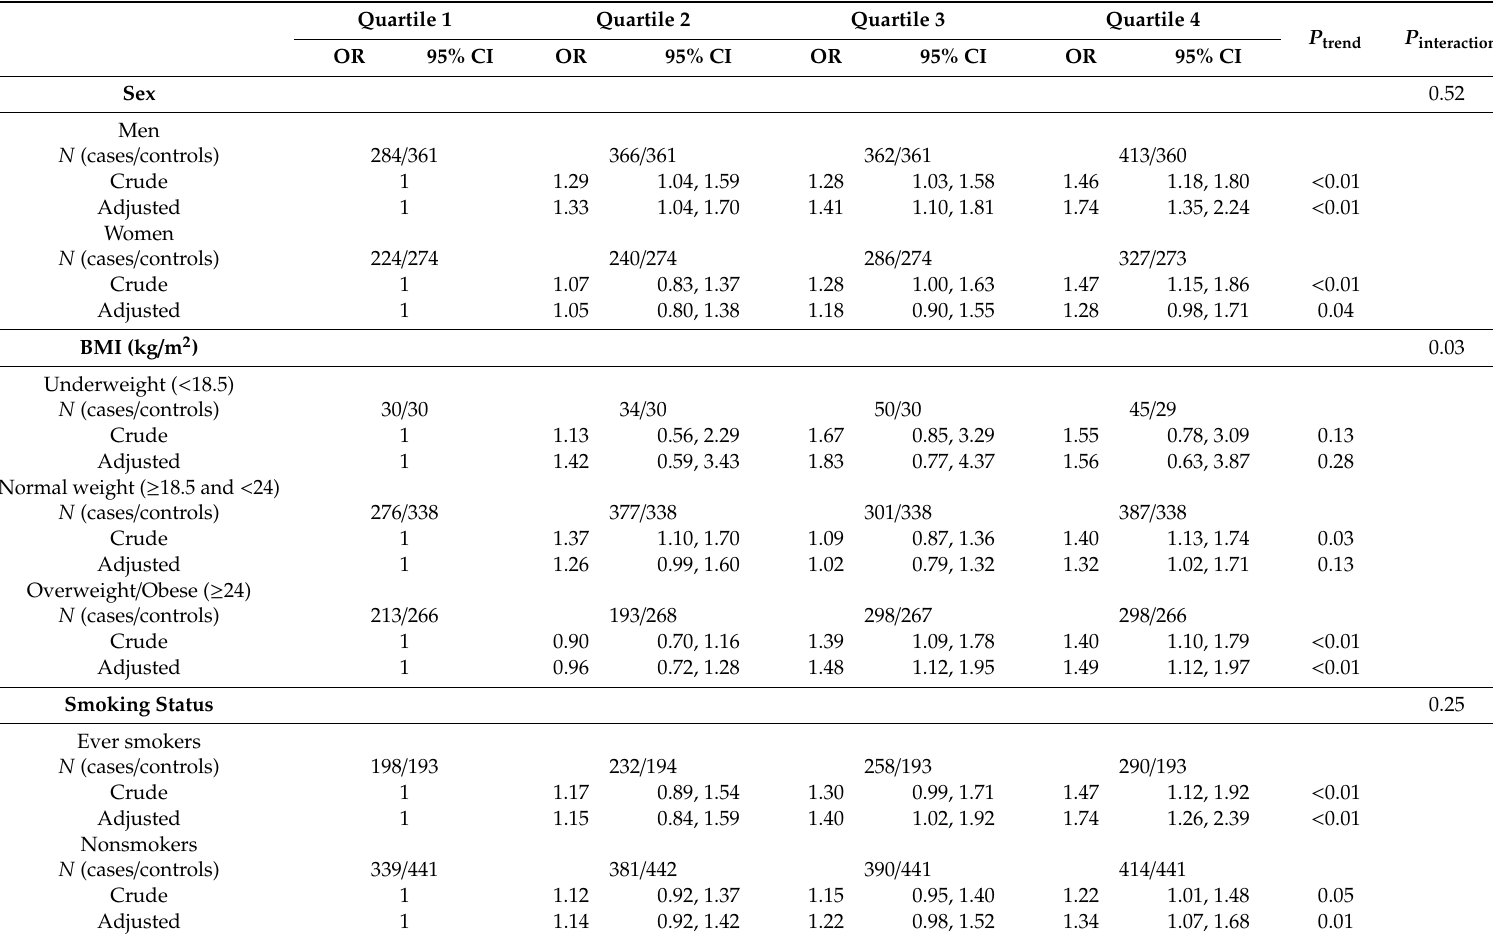
Table 4. Odds ratios and 95% confidence intervals of colorectal cancer for the energy-adjusted dietary inflammatory index (E-DII) score stratified by selected factors in a Chinese case-control study, 2010–2019 a